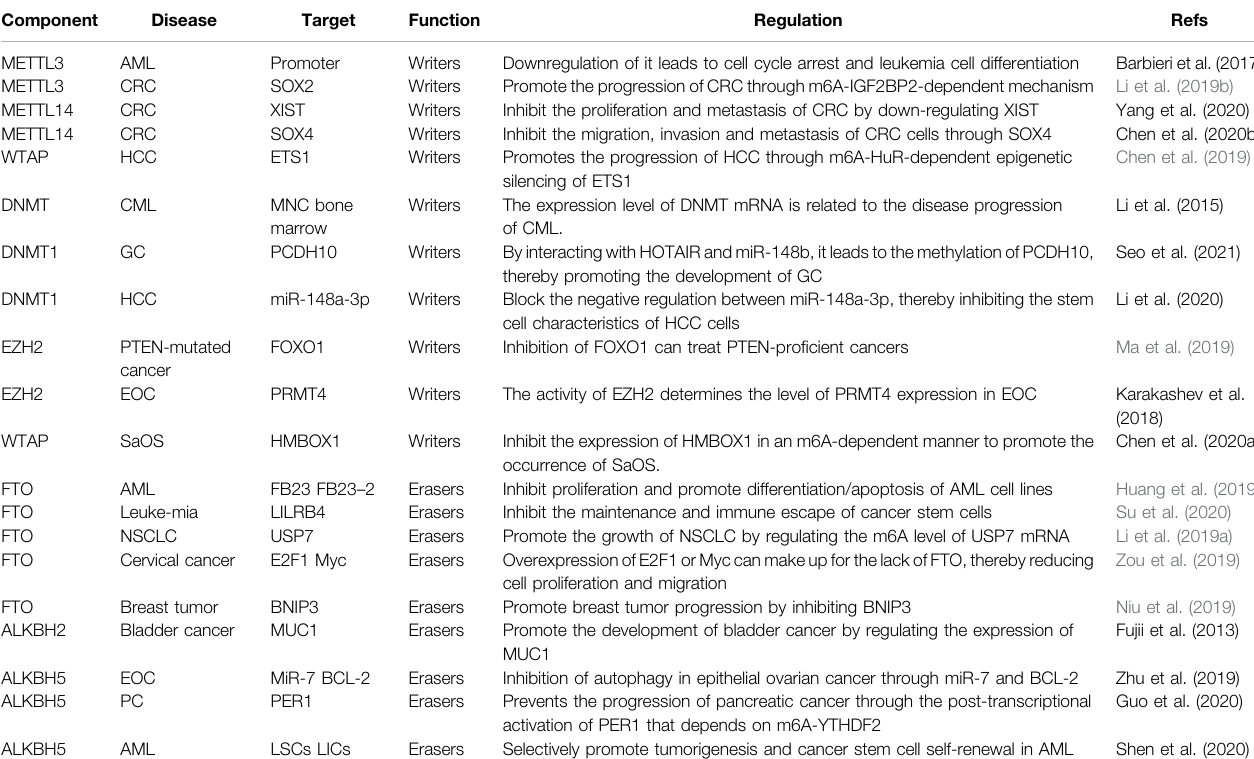
TABLE 1 | Describe the author and eraser mechanism in